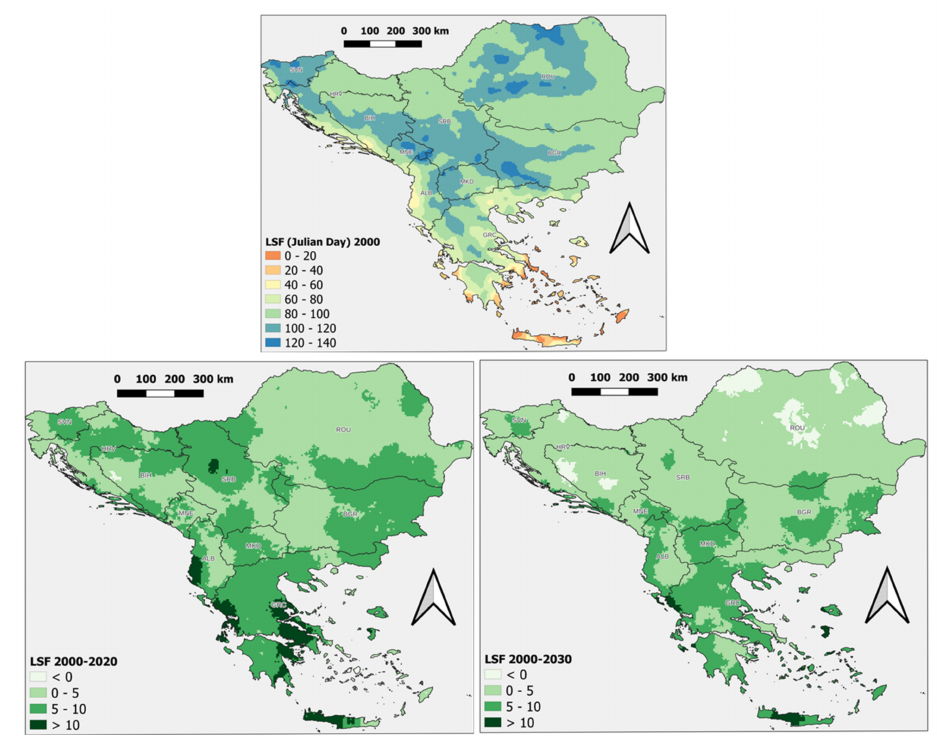
Figure 6. Last Spring Frost (LSF) in Julian days. Reference period ( upper image), the difference between the reference period and the 2020 horizon ( down left ) and the difference between the reference period and 2030 horizon ( down right ).